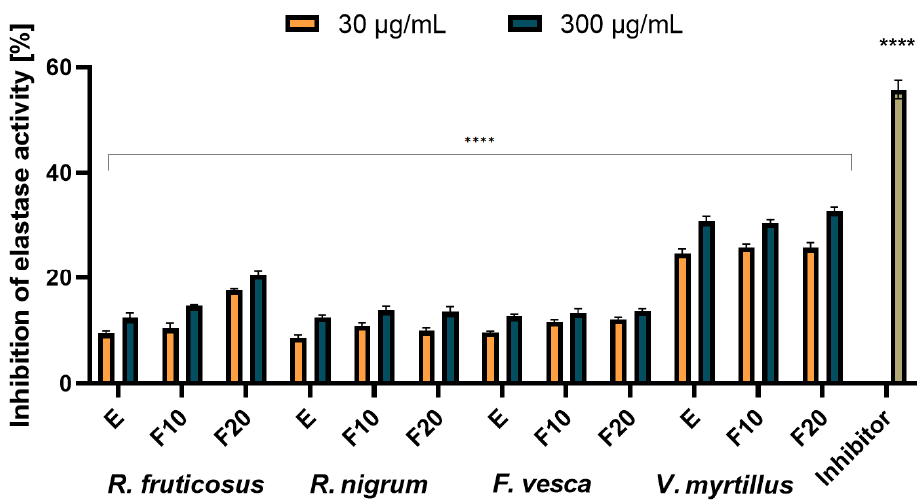
Figure 9. Elastase inhibitory activity of R. fruticosus L., R. nigrum L., F. vesca L., V. myrtillus L. extract and kombucha ferments at concentrations of 30 and 300 µ g/mL. Data are the mean of three independent experiments, each consisting of two replicates per treatment group. **** p < 0.0001 versus the control.